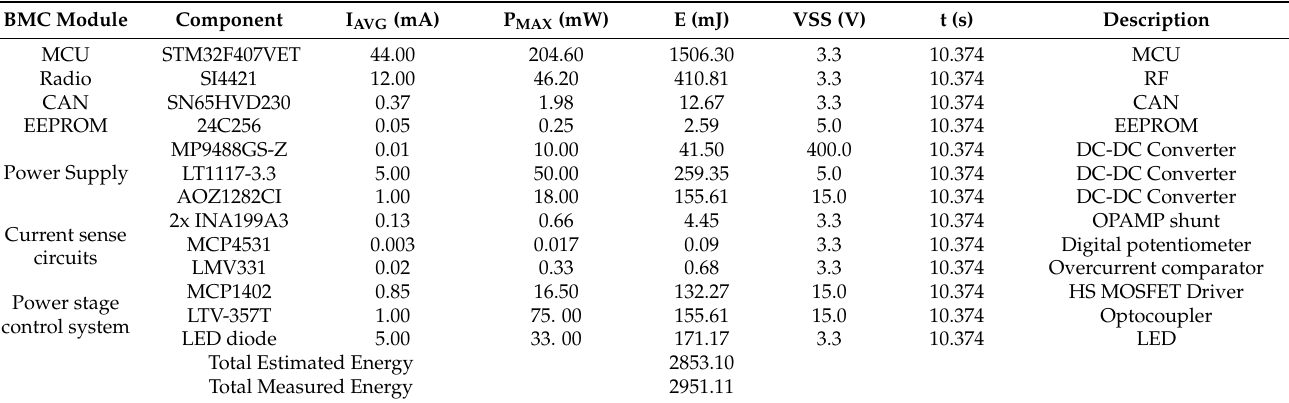
Table 2. Rated power requirements of the BMC components in normal operation